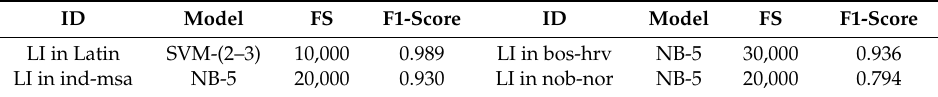
Table 16. Selected OCM for LI in Latin script and SLI in three SLG in three-stage LI-1.